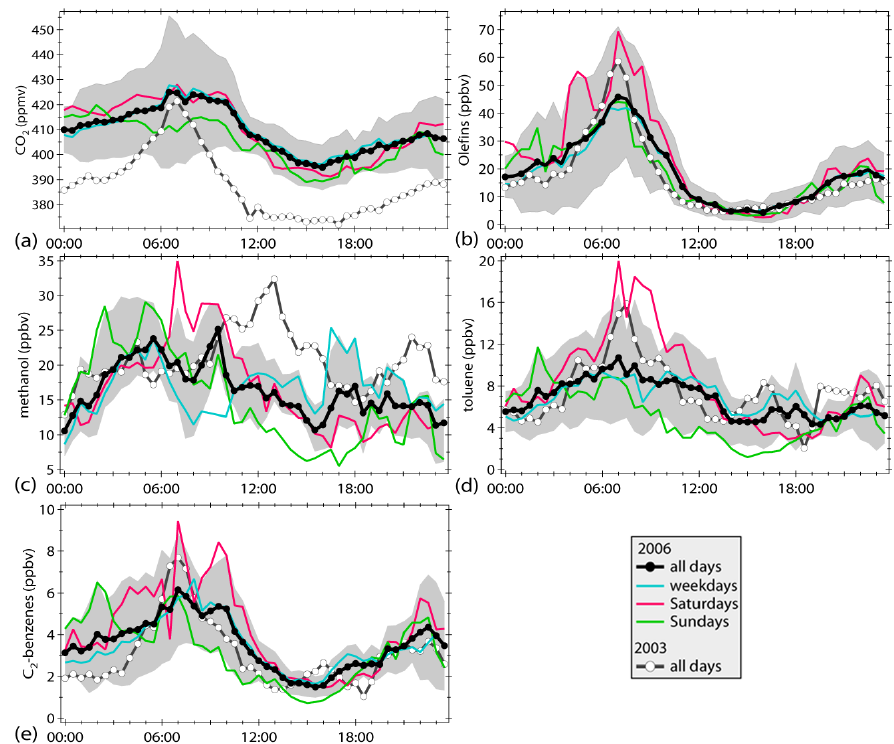
Fig. 2. Average diurnal patterns of ambient concentrations of (a) CO 2 , (b) mix of olefinic VOCs detected by the FOS, (c) methanol, (d) toluene, and (e) C 2 -benzenes for the entire study, weekdays, Saturdays and Sundays. The ambient concentrations measured in 2003 at the CENICA site are included as reference. The grey shadows represent ± 1 standard deviation from the total 2006 averages, and give an indication of the day-to-day variability in each phase of the daily cycle. The time scale corresponds to the local standard